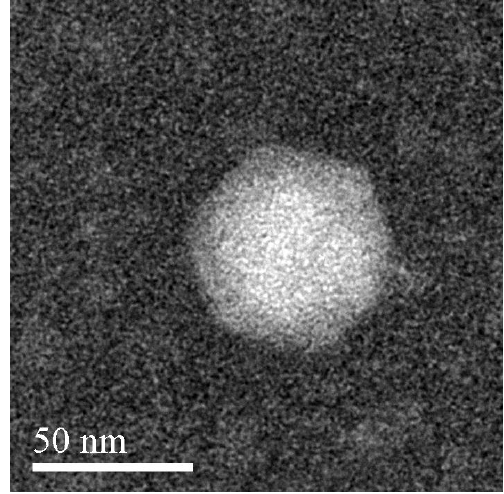
Figure 1. Negatively stained transmission electron microscopy image of the Aquamicrobium phage